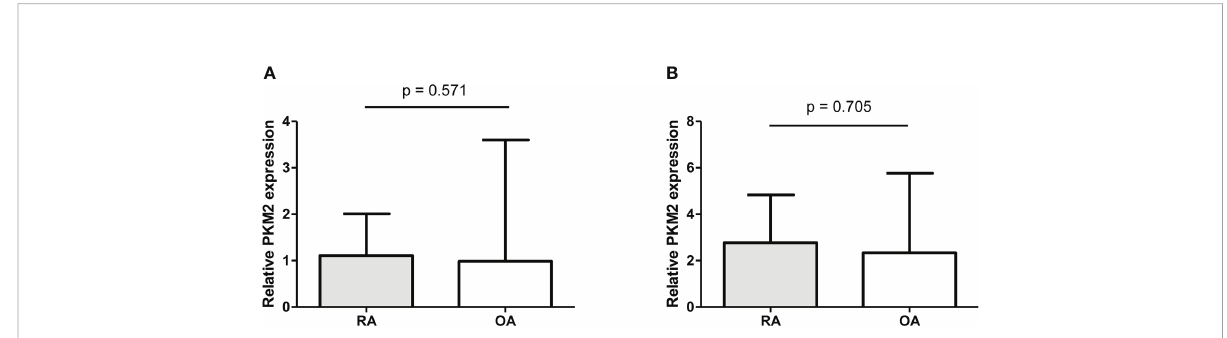
FIGURE 7 Real-time quantitative polymerase chain reaction of PKM2 in synovial tissues from RA and OA patients. The relative expression of PKM2 in knee synovial tissues was comparable between RA and OA patients (n=10); this was analysed using two different primer sequences: (i) (A) and (ii) (B) . Relative PKM2 expression was compared by the Mann-Whitney U test. The error bars indicate median values and interquartile range. PKM2: pyruvate kinase isoenzyme M2; RA: rheumatoid arthritis; OA: osteoarthritis.